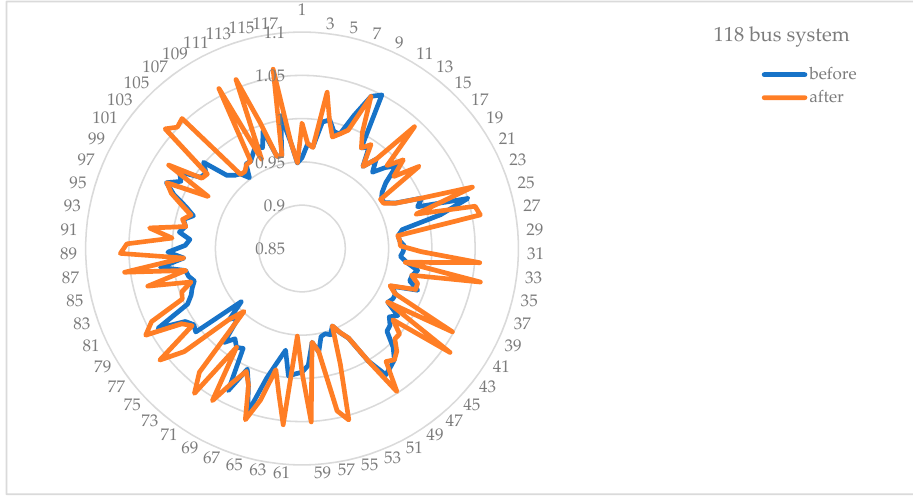
Figure 13. Power losses obtained by different optimization methods for 118 bus system. Table 9. IEEE 118-bus system’s first case objective performance.